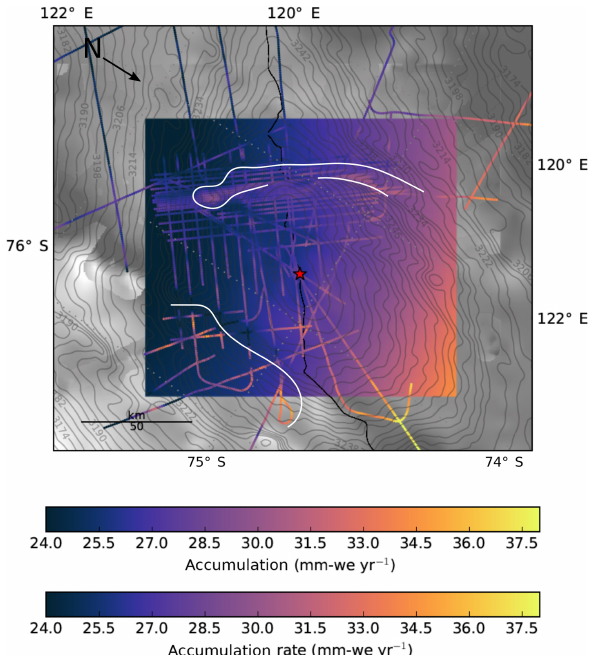
Figure 6. Spatial anomaly of paleoaccumulation for the 0–10ka age interval. Residual paleoaccumulation rates displayed are overlain on surface curvature in the prevailing wind direction (CPWD, strongly positive and negative values are sketched on either end of the color bar). Black lines outline the same areas of small-scale high accu- mulation as on Figs. 3 and 5. Results are filtered to remove regions of excess horizontal strain. The residual paleoaccumulation highs correlate well to areas of strongly positive CPWD. A blue arrow indicates prevailing wind